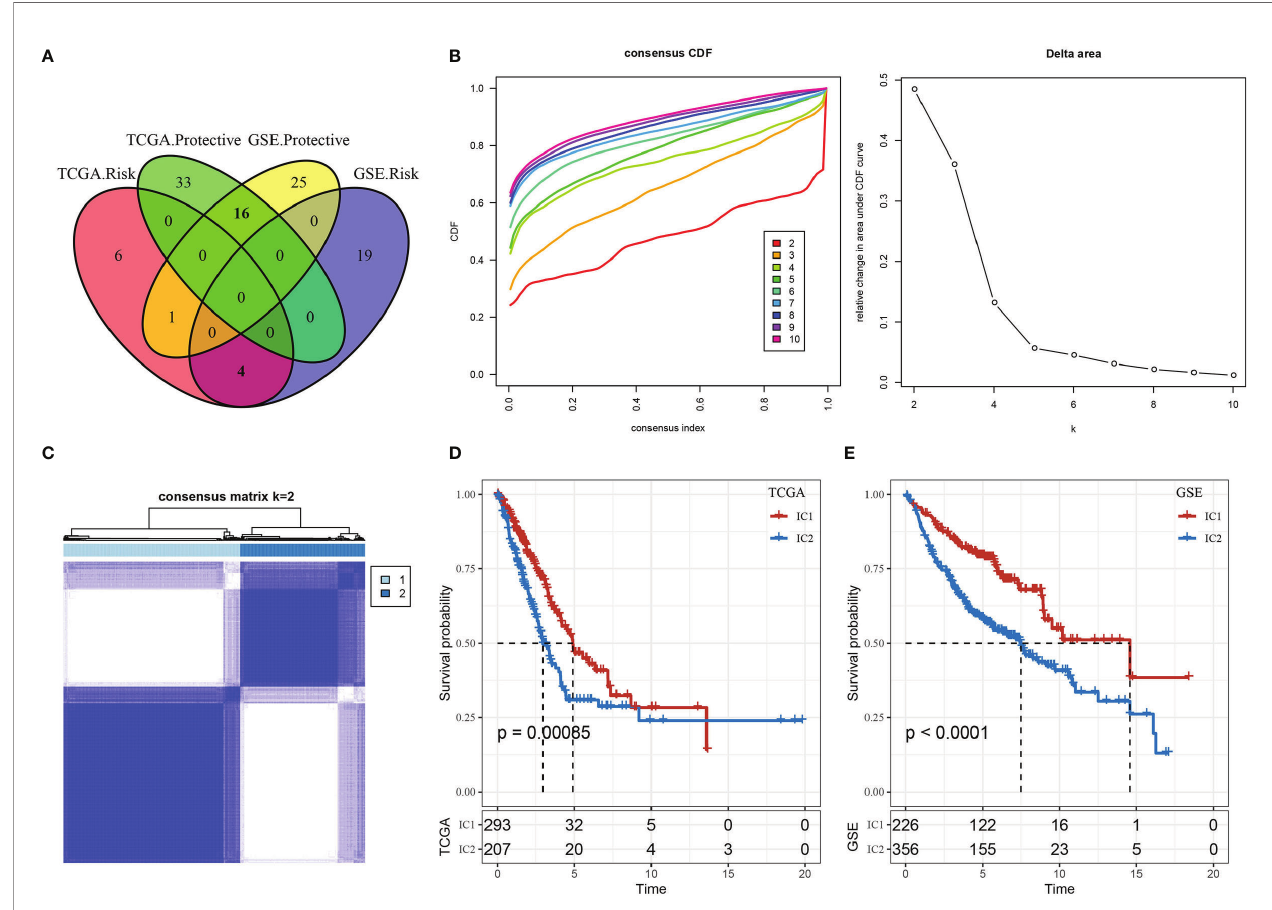
FIGURE 3 | Immune clusters (ICs) in lung adenocarcinoma (LUAD). (A) Venn diagram displaying the intersection of CD8 + T cell genes signi fi cantly associated with prognosis between the two cohorts (TCGA-LUAD and GSE-LUAD). (B) Cumulative distribution function (CDF) curve and CDF delta area curve of TCGA- LUAD samples: delta area curve of consensus clustering indicates the relative change in area under the CDF curve for each category number k compared with k – 1, where the horizontal axis represents the category number k, and the vertical axis represents the relative change in area under CDF curve. (C) Heat map of sample clustering at consensus k = 2. (D) Survival curves for the molecular subtypes in the TCGA-LUAD cohort. (E) Survival curves for the molecular subtypes in the GSE-LUAD